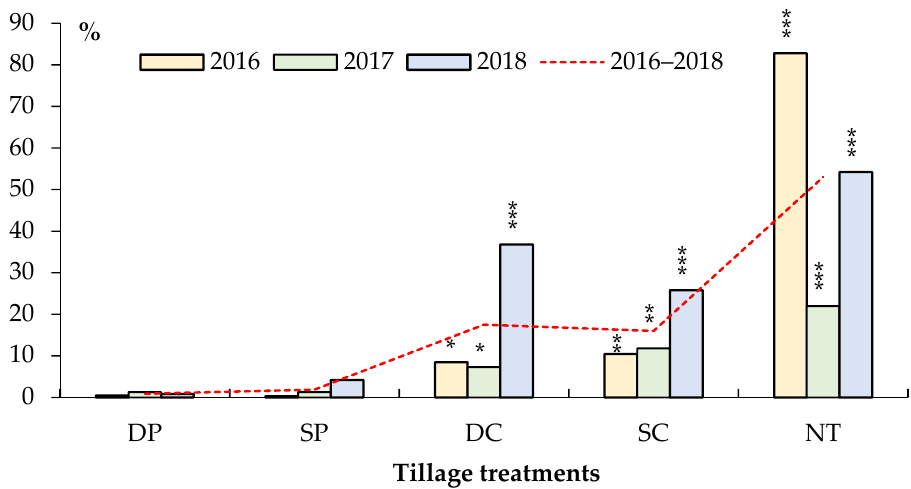
Figure 2. The volume of fore crop residues in the topsoil of differently tilled soil after faba bean sowing. DP—deep plowing (control treatment), SP–shallow plowing, DC–deep cultivation, SC– shallow cultivation, NT–no-tillage (direct drilling). * significant difference at 0.01 < p ≤ 0.05, ** at 0.001 < p ≤ 0.01, *** at p ≤ 0.001. p > 0.05 indicates no significant difference compared with DP.